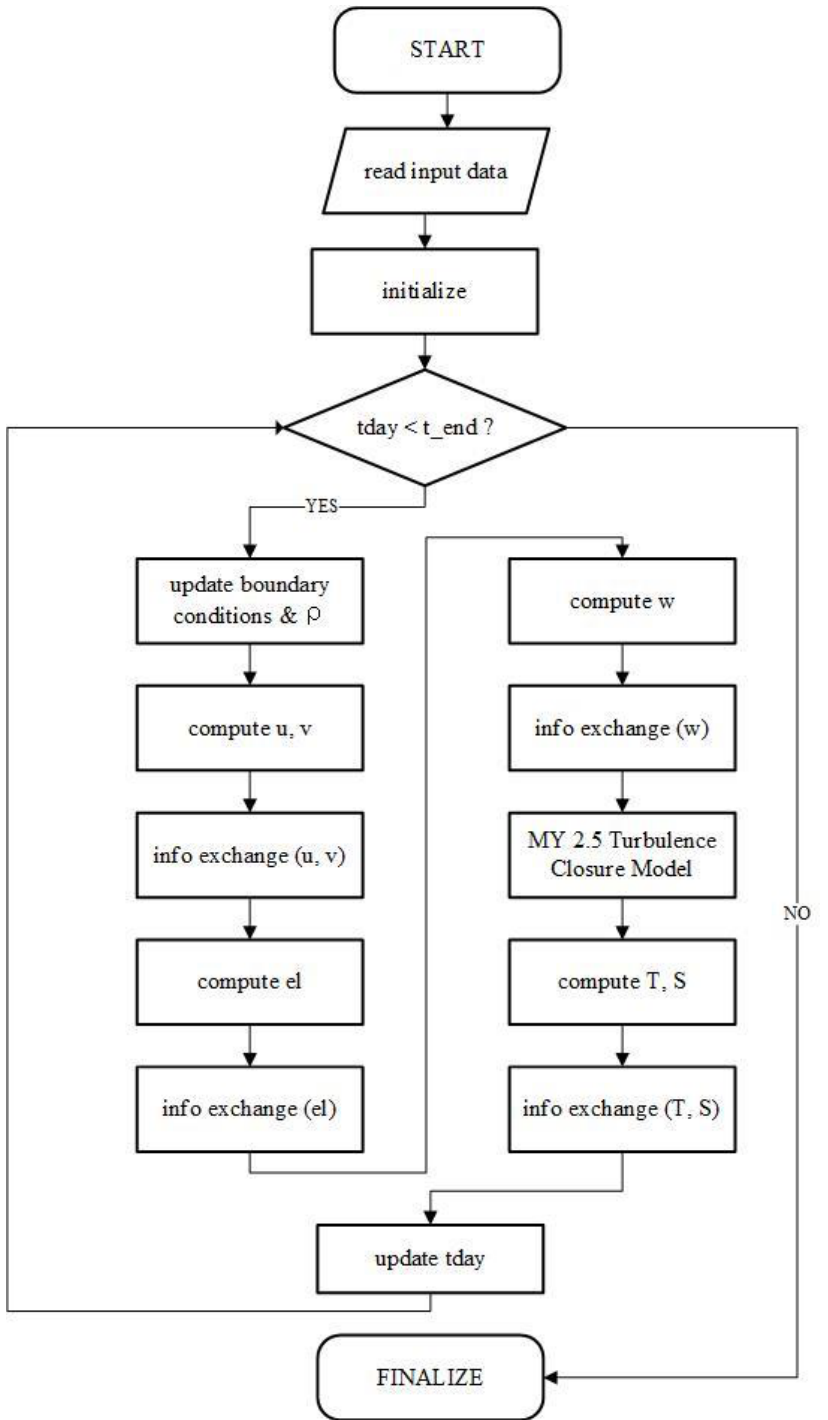
Figure 3. The general algorithm of unstructured quadrilateral grid, finite-differencing, estuarine and coastal ocean model (UFDECOM).